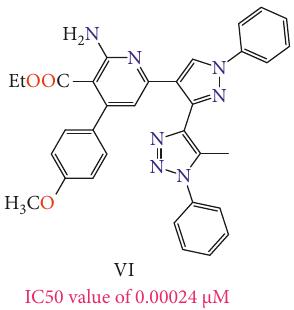
Figure 11: Aromatase inhibition activity of 1,2,3-triazole derivative (VI).